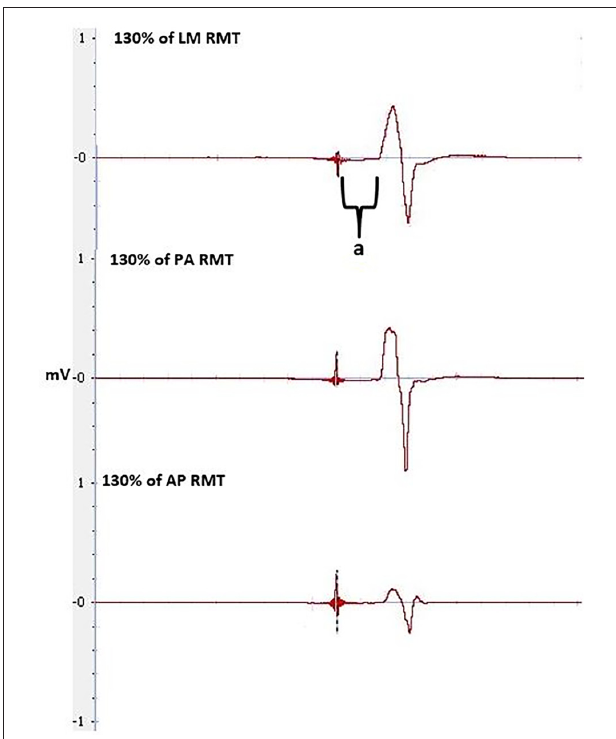
FIGURE 6 | MEPs at 130% of RMT at LM, PA and AP orientation, pre-tDCS, used to calculate latencies and latency difference. Latency is between the stimulus to the onset of the MEP, indicated by a .